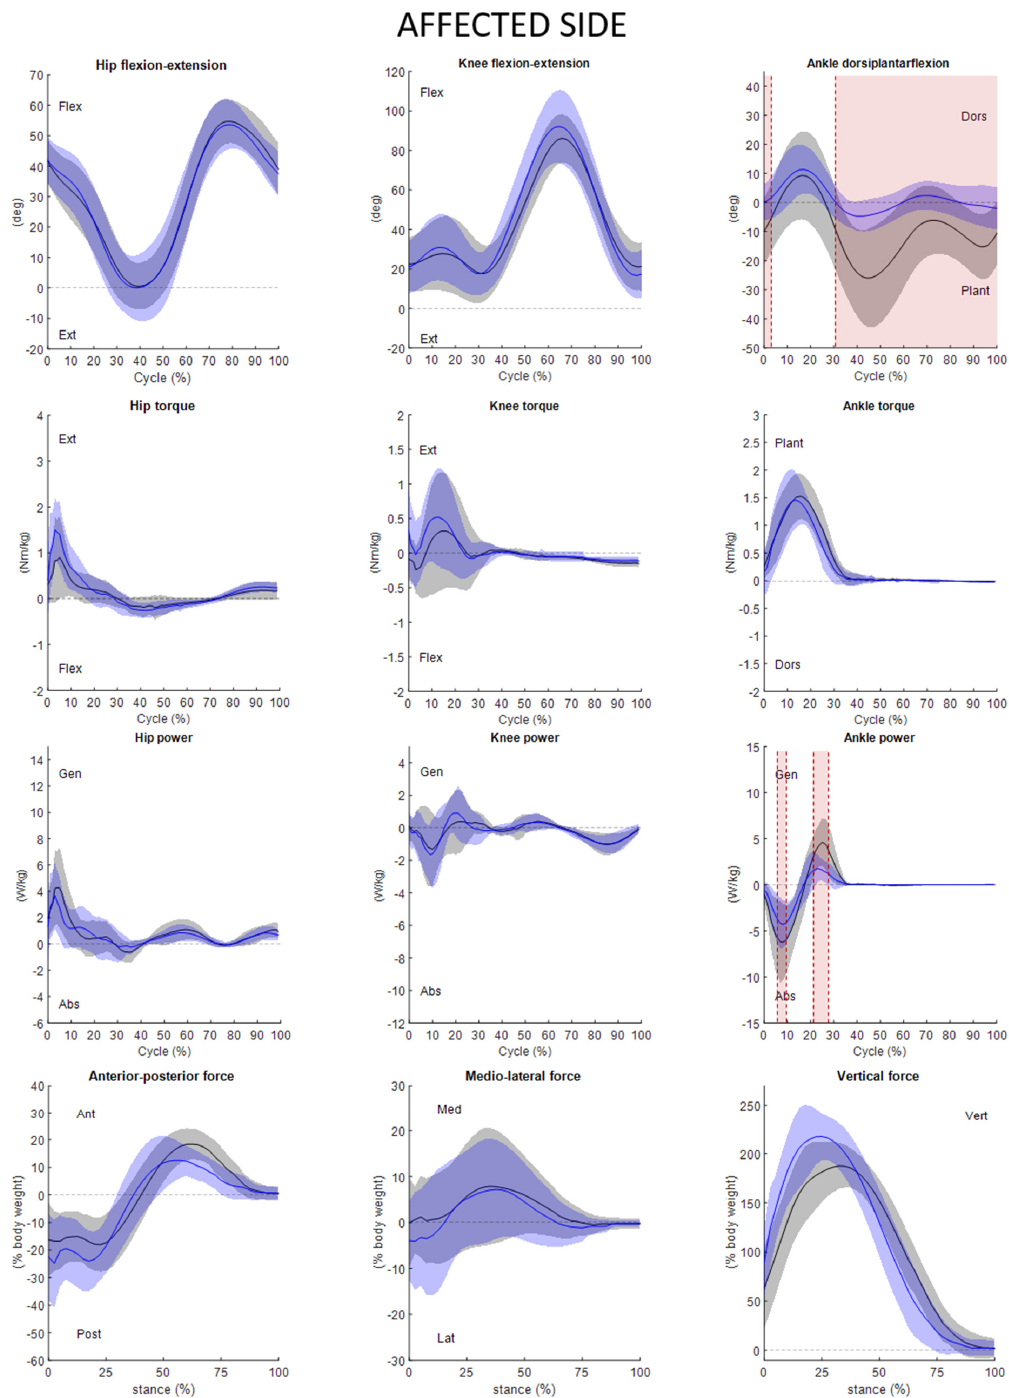
Figure 2. Hip knee ankle kinematic (1st line), torque (2nd line), power (3rd line), and ground reaction forces (4th line) of the affected side. Kinematic and kinetic variables are expressed as a function of the running cycle (Cycle (%) or %GC) while GRFs have been normalized with respect to stance phase (stance (%)). Mean and SD of the barefoot (in black) and the orthotics (in blue) trials are depicted. The SPM statistics results (SPM{t}) are shown in red. Flex = flexion; Ext = extension; Dors = dorsiflexion; Plant = plantarflexion; Gen = generated; Abs = absorbed; Ant = anterior; Pos = posterior; Med = medial; Lat = lateral; Vert =